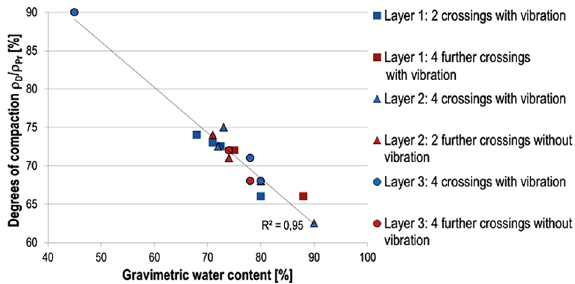
Fig. 3. DOC for M1 and different installation and compaction modes with/ without vibration, variation of crossings